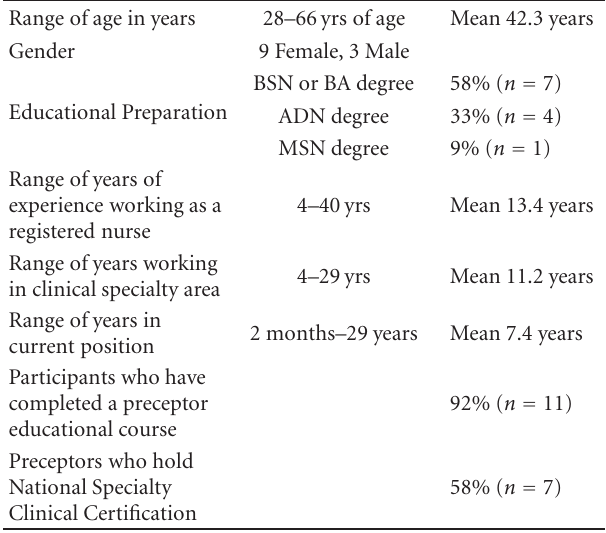
Table 1: Participant demographic data.